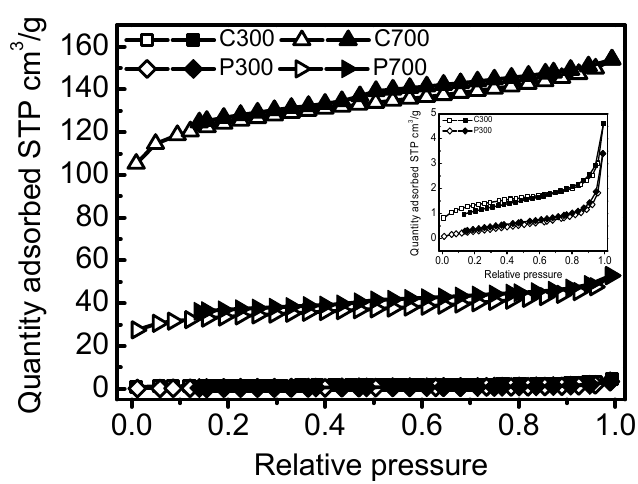
Table 2. Elemental composition (on a dry mass basis) and atomic ratios of biochars. Figure 2. Adsorption and desorption isotherms for biochars. The hollow signs are for the adsorption